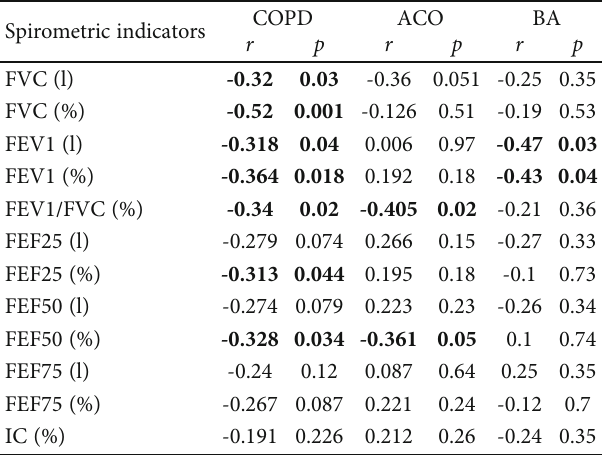
Table 5: Correlation between the serum concentration TNF- α and the lung function parameters in patients with COPD, asthma- COPD overlap, and bronchial asthma. Spirometric